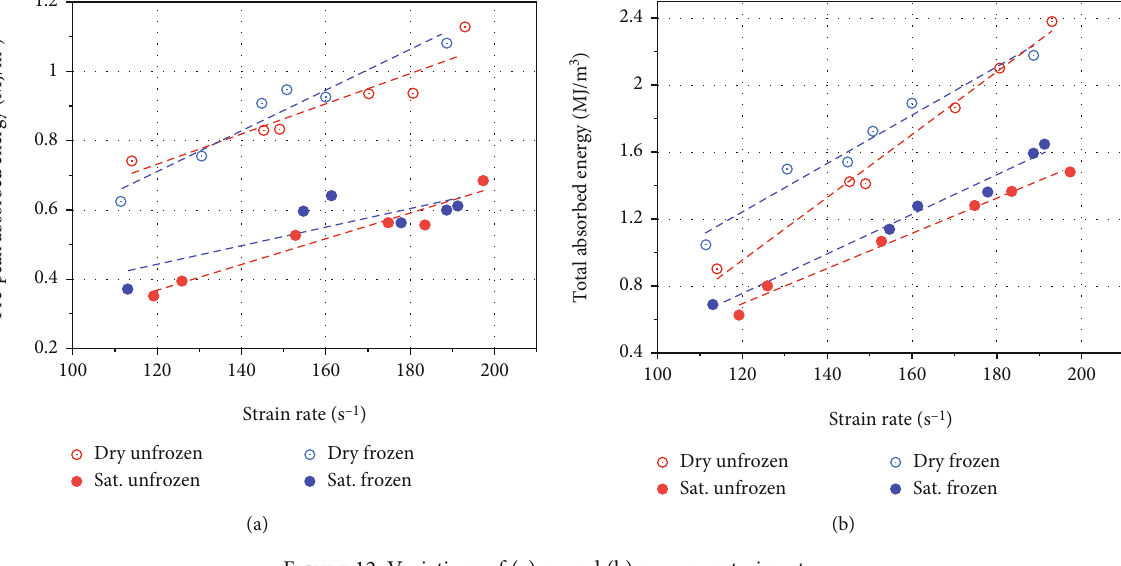
e f and (b) t versus strain rate.